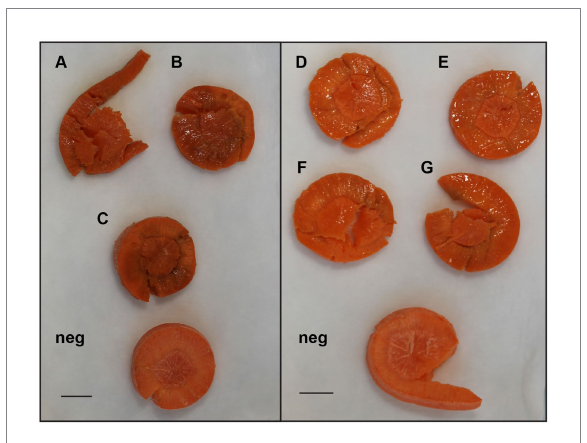
FIGURE 4 Examples of differences in soft rot caused by select E. persicina and Pectobacterium isolates after 48 h. To visualize differences in virulence, sterilized carrot slices were inoculated with 10 μ l of overnight cultures of soft rot causing isolates that were washed and resuspended in a buffer solution and incubated at 30 ° C for 48 h. Isolates used were Pectobacterium versatile SR1 (A) , Pectobacterium brasiliense SR10 (B) , P. versatile SR12 (C) , and E. persicina SR13-16 [ (D–G) , respectively]. Negative controls (Neg) were inoculated with sterile buffer solution. Scale bar equals 1 cm. E. persicina isolates are still in the first stages of causing soft rot symptoms (water soaking), while the Pectobacterium isolates have already progressed to the latter stages of the disease (darkened spots of tissue